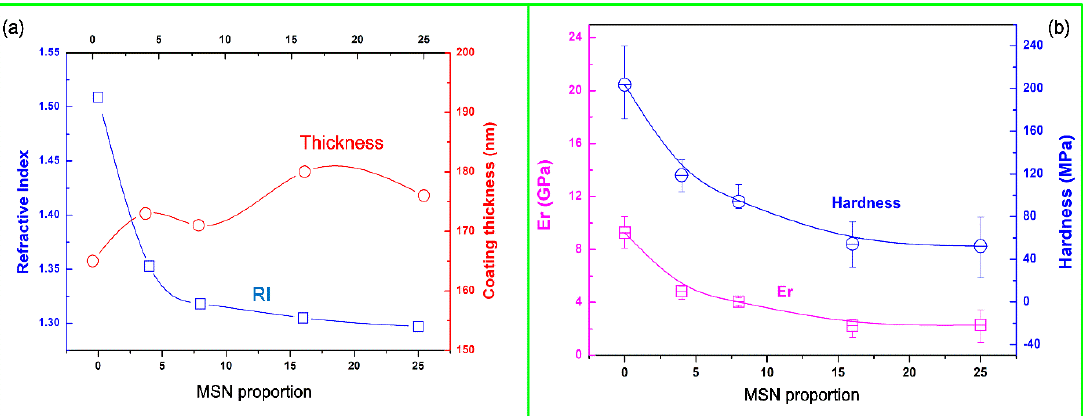
Figure 3. Characterizations of polysiloxane coatings with various MSN embedding proportions, ( a ) RI and thickness results from ellipsometry, ( b ) hardness and elastic modulus Er results from nanoindentation.